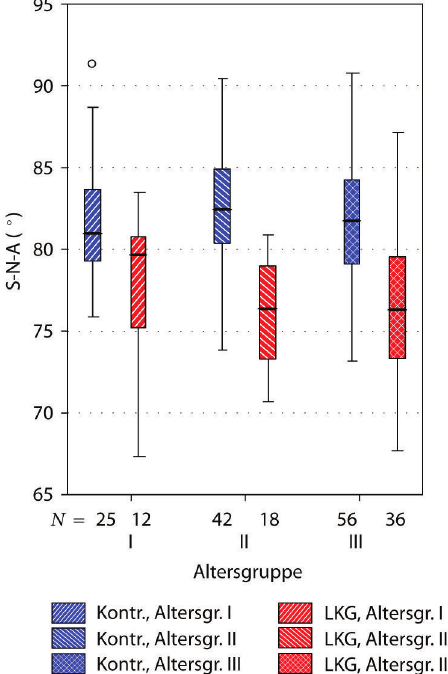
Figure 6: Boxplot illustrating significant di ff erences between uCLP group and controls concerning maxillary position (angle